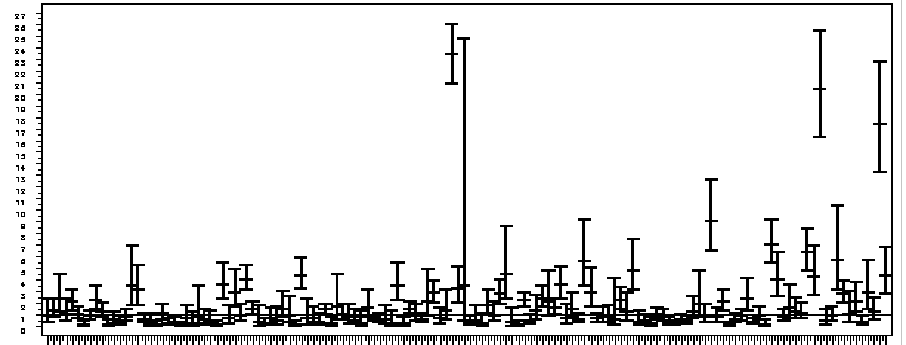
Figura 2 – y 2 dimissioni volontarie intervalli di confidenza per cosp.